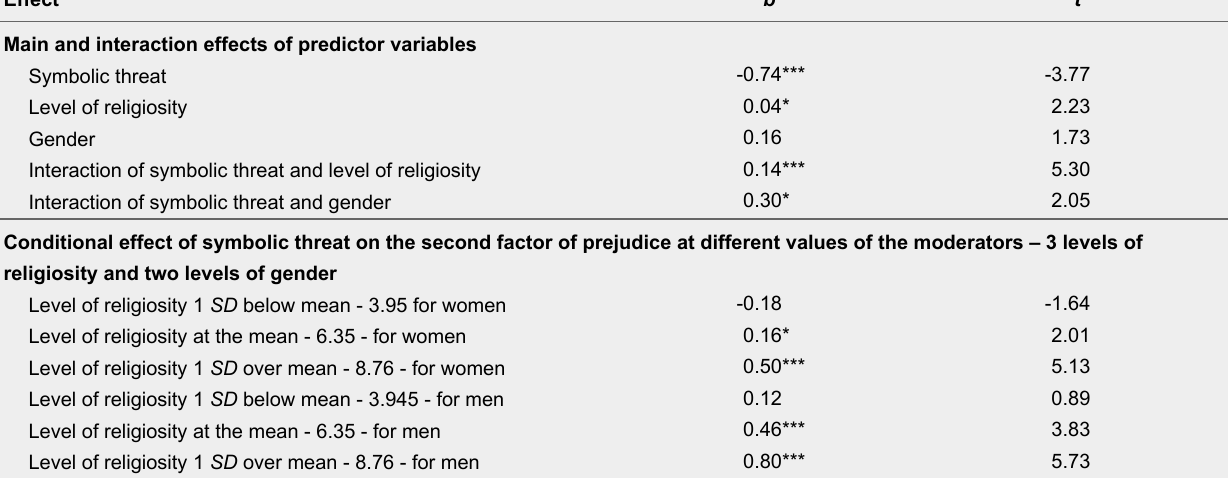
b Coefficients for the Model 4: Symbolic Threat, Religiosity and Gender on the Second Factor of Prejudice